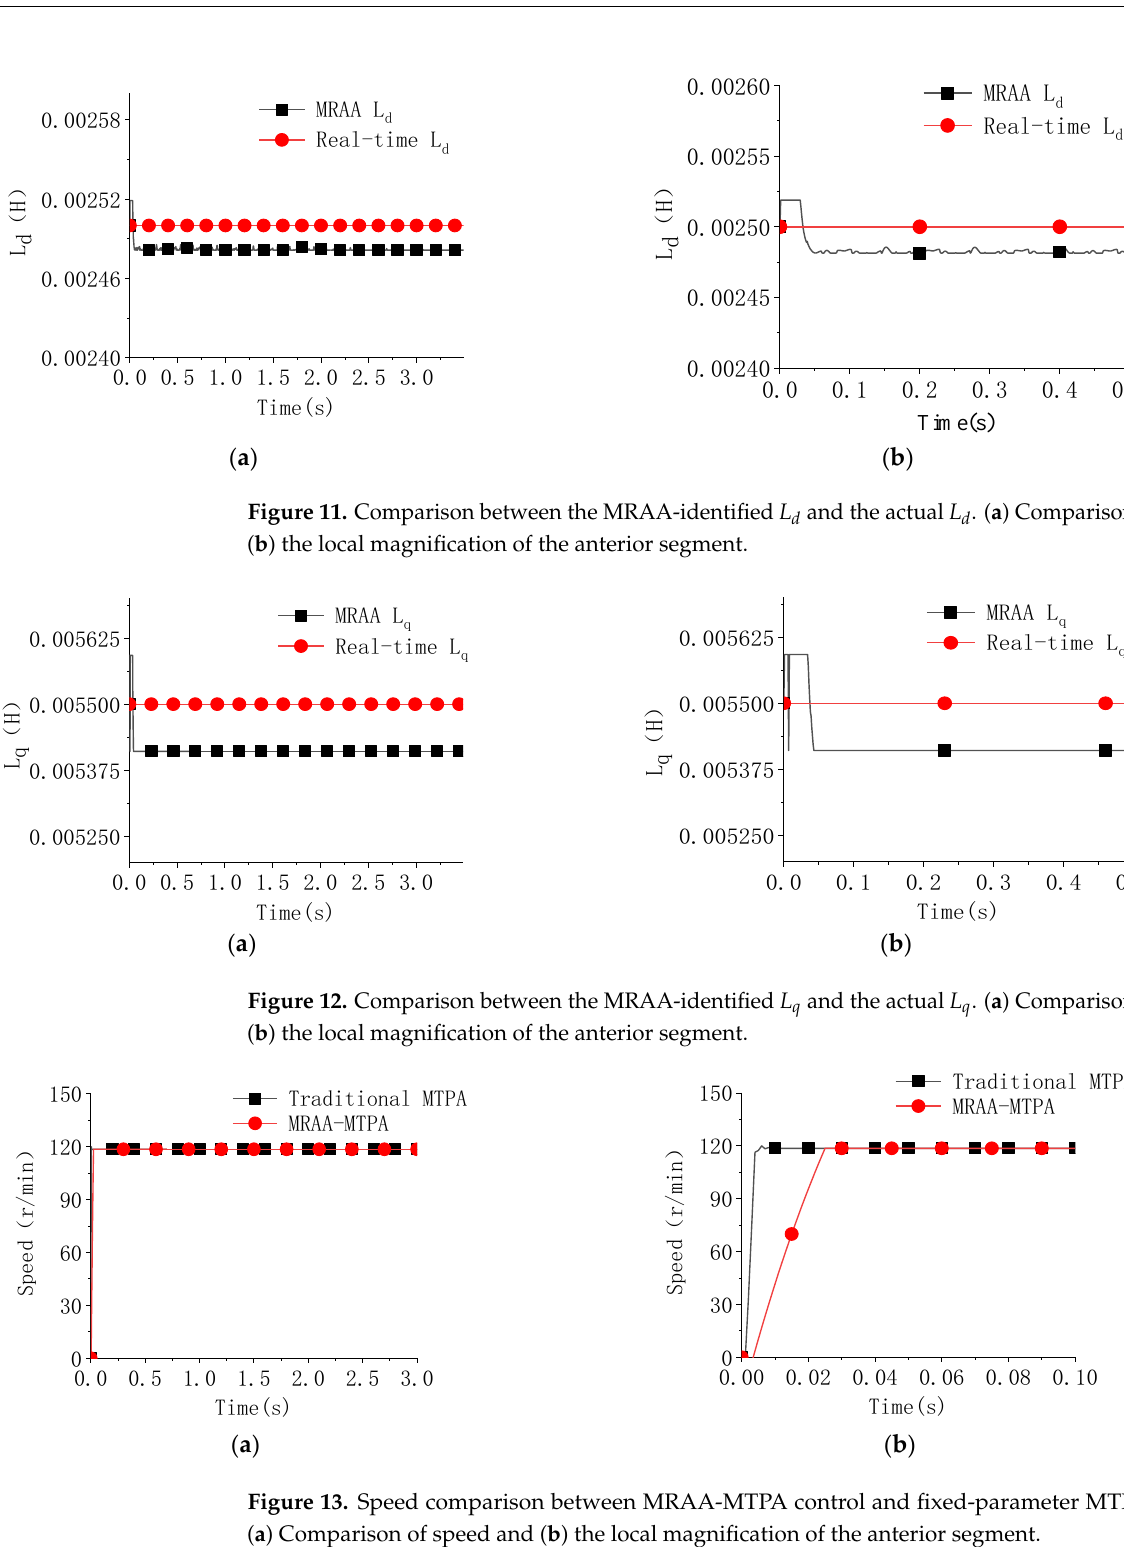
( b ) Figure 14. Comparison between MRAA-MTPA control and fixed-parameter MTPA control. ( a ) Comparison of stator current and ( b ) the local magnification of the starting segment. 5. Conclusions Electric construction uses an electric motor that easily cancels the engine, which can improve efficiency and achieve zero emissions. However, the existing electric construc- tion machinery mostly uses the motor to replace the working engine and simulate the working condition of the engine. The load is matched with the speed, torque, and power of the motor through the hydraulic torque converter, which cannot maximize the energy efficiency of the whole machine. This paper aims to understand the load direct-drive mo- tor system of electric construction machinery, such as the direct-drive system of the loader traveling motor. The high-performance motor control method in the state of low speed and high torque is studied. Based on the vector control of the maximum torque per am- pere of IPMSM, an MRAA is employed. By establishing the motor reference model and taking the motor voltage and current as the input physical quantity, the parameters of the